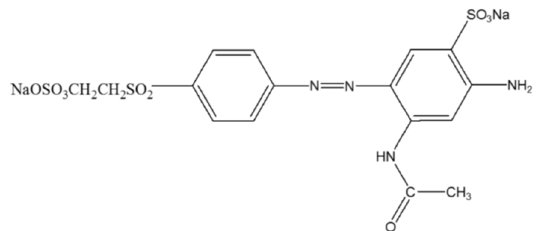
Figure 1. Molecular structure of Remazol Golden Yellow dye (RNL). Adapted from Alvarenga et al. 37